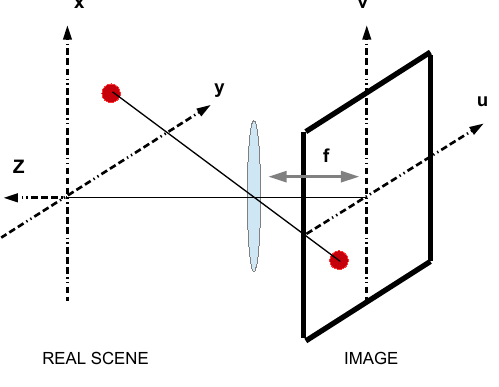
Figure 5. Pinhole camera